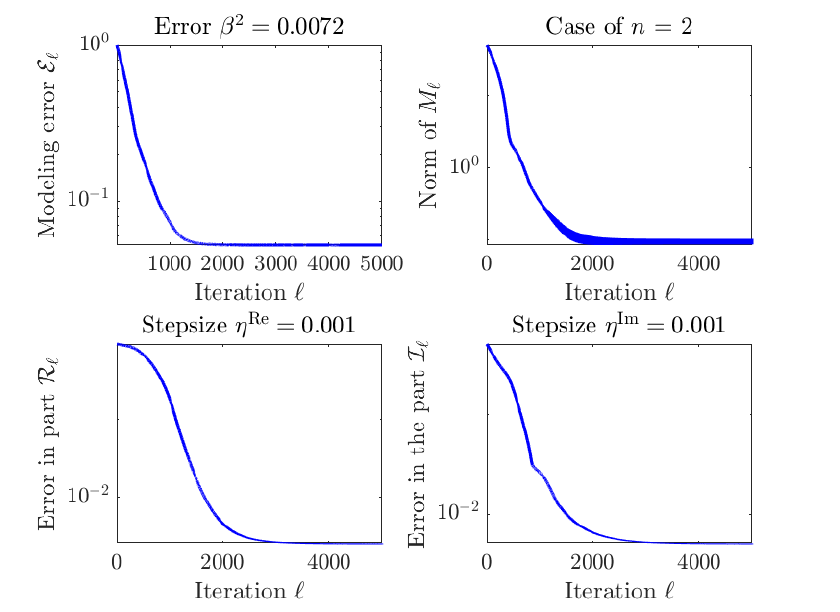
Figure 6. Results of a numerical experiment by the Riemannian-gradient-based geodesic-stepping optimization algorithm in the case that n =